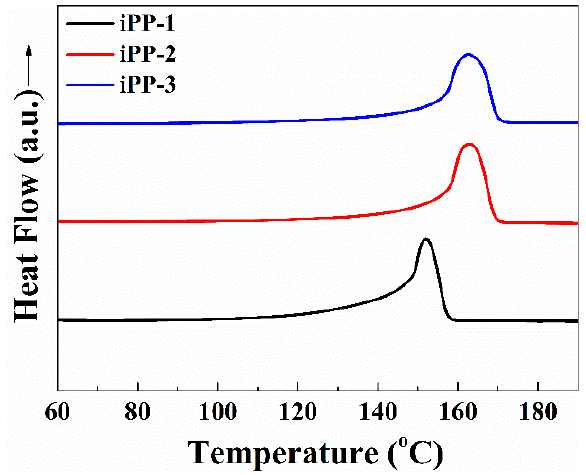
Figure 2. DSC curves of the iPP samples. Table 2. Melting temperatures ( T m ), melting enthalpies ( Δ H m ), and crystallinity indices ( χ c ) of the as-